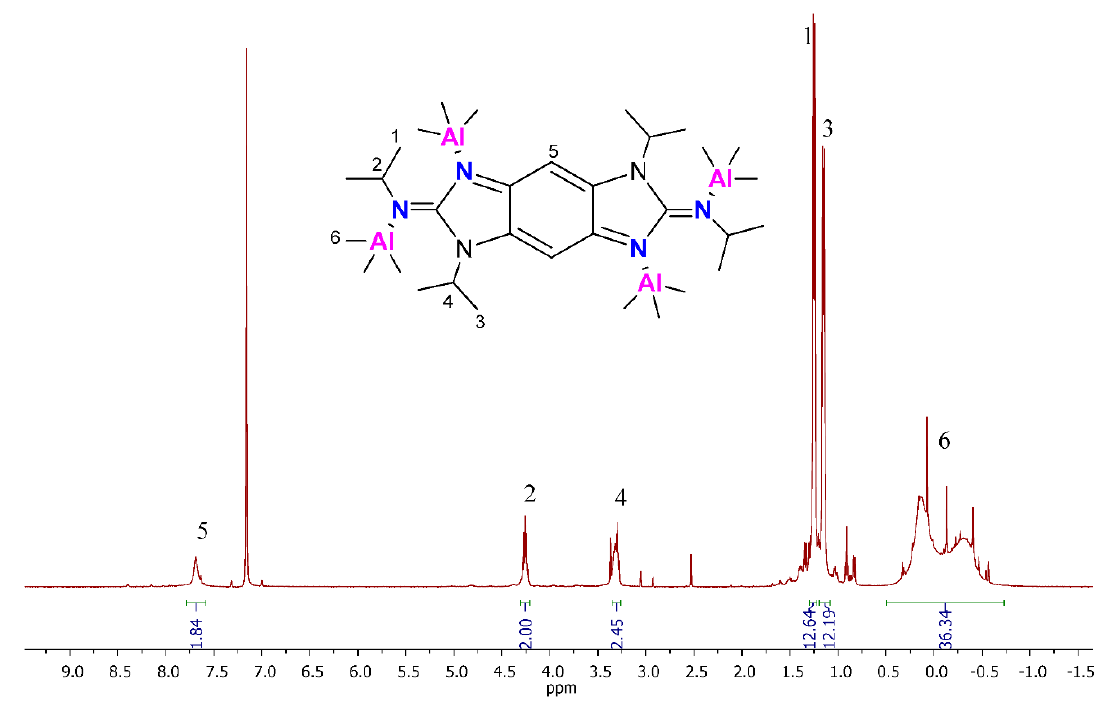
Figure 3. 1 H NMR spectrum of alkyl aluminum adduct 1 in C 6 D 6 .